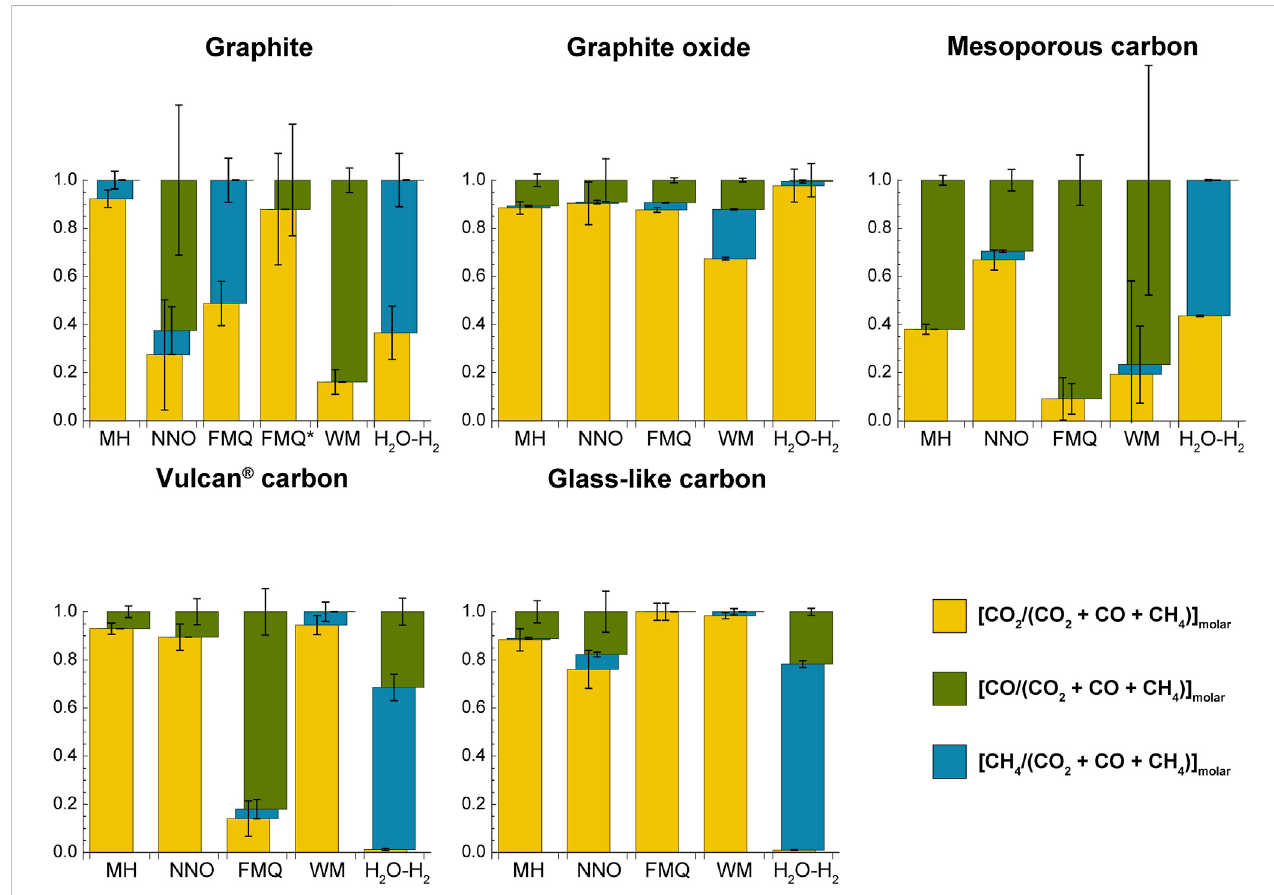
FIGURE 4 Proportion of volatile carbon species in the COH fl uid coexisting with the various carbon forms at the speci fi ed redox conditions. See the text for the calculation and Table 4 for the data used to produce the fi gure.